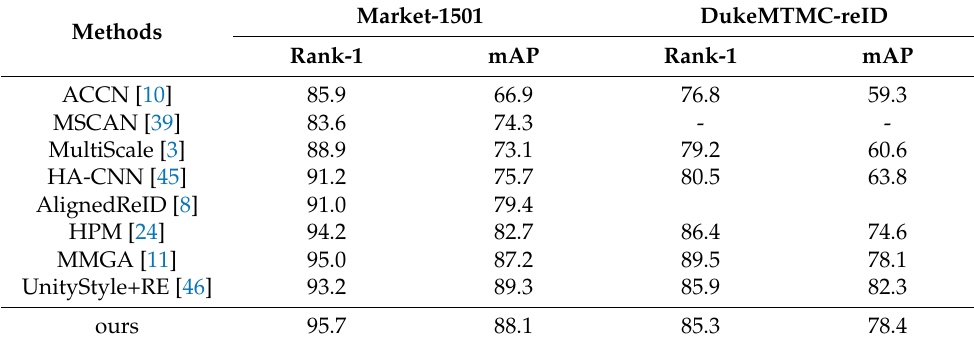
Table 4. Comparison of results on Market-1501 and